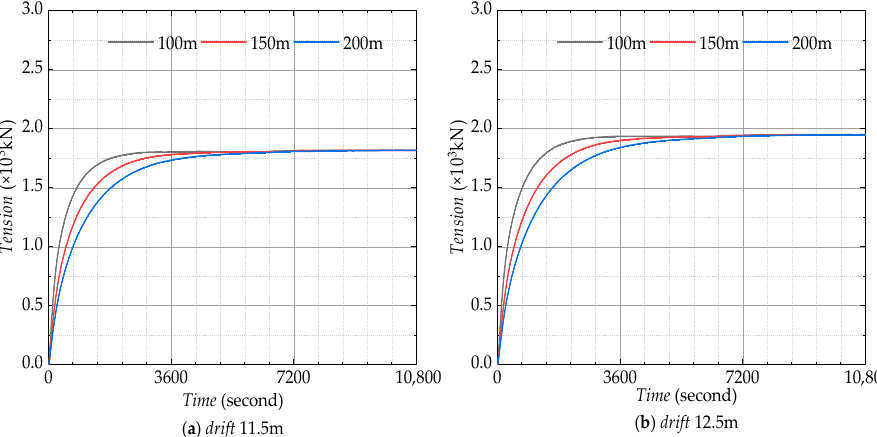
Figure 15. Towrope tension at different drift depths and towrope lengths.